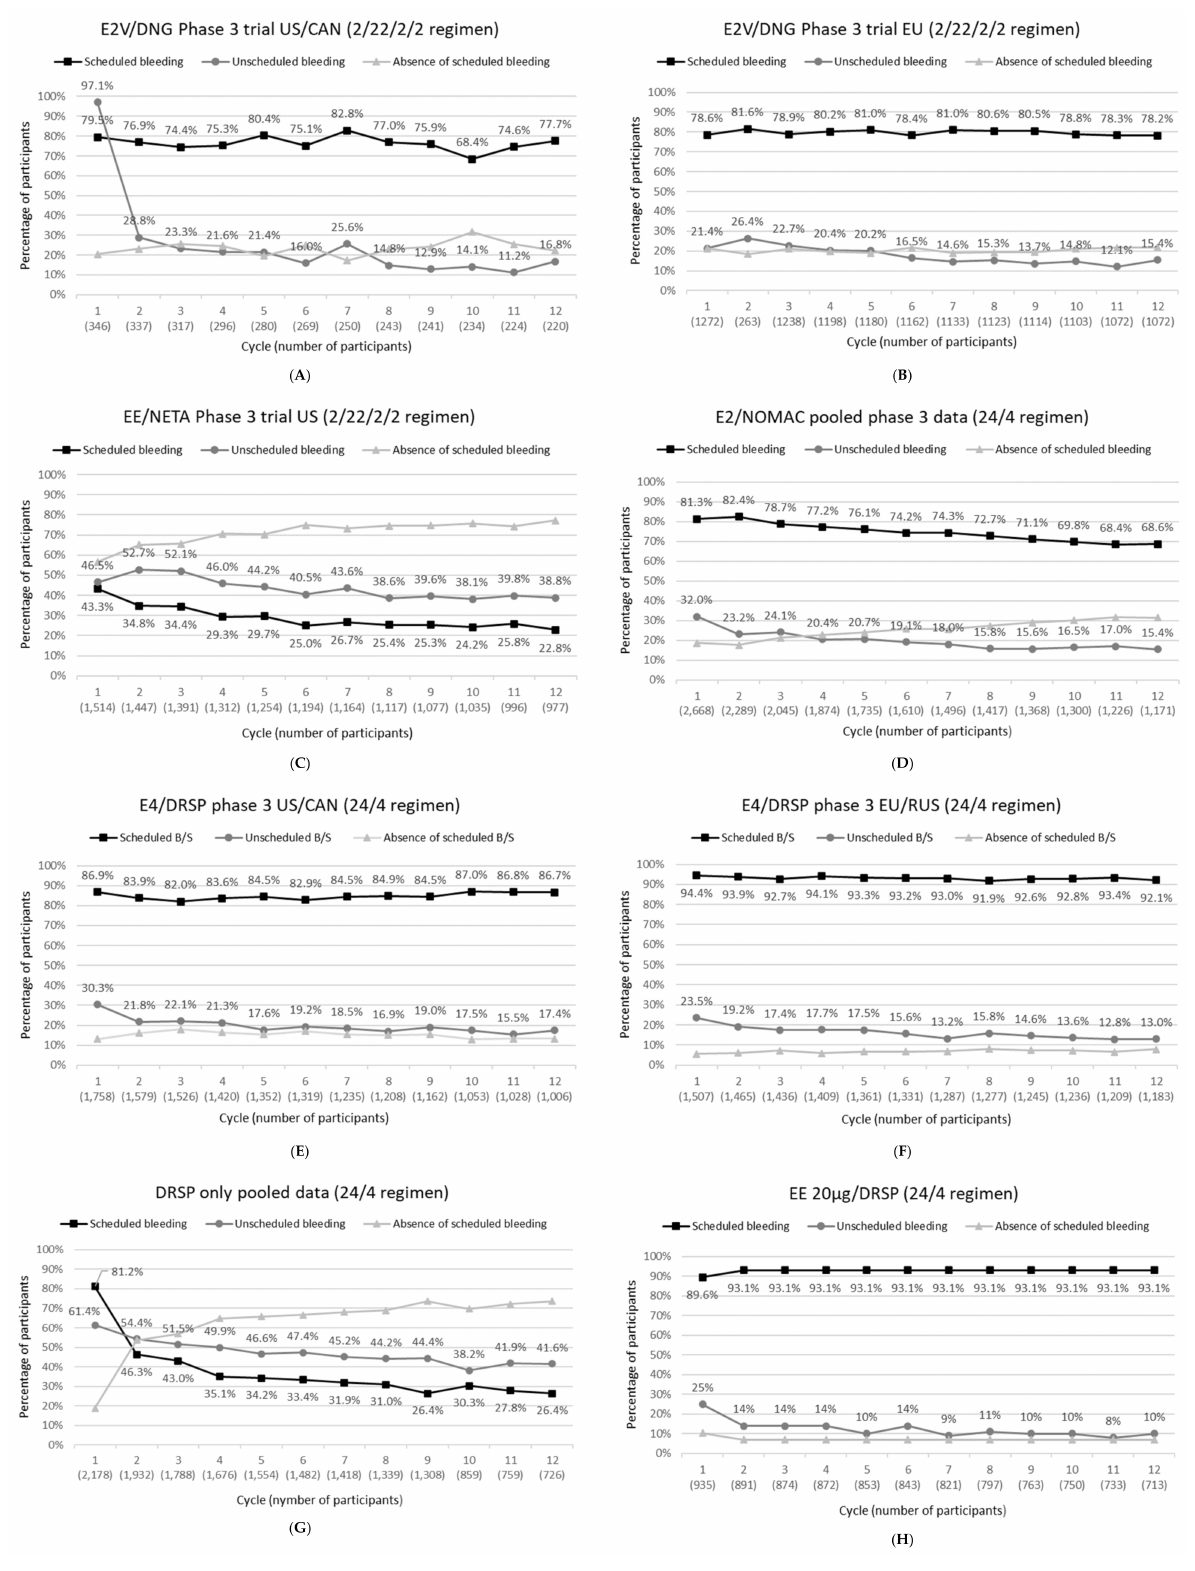
Figure 1. ( A – H ): Incidence of scheduled bleeding, unscheduled bleeding and absence of scheduled bleeding for each OC listed above each subfigure as a function of cycles. Footnote for Figure 1: Data included: E2V/DNG trials NCT00206583 and NCT00185289; EE/NETA trial NCT00391807; E2/NOMAC pooled data of trials NCT00511199l